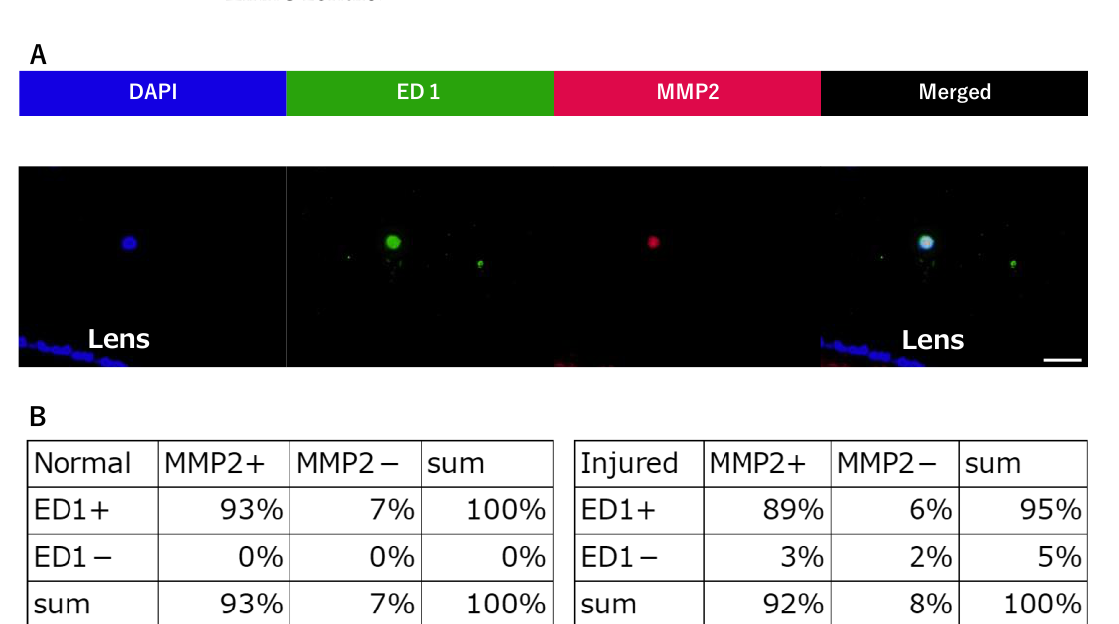
Figure 2. Increased infiltration of ED1-positive and MMP2-positive cells in Zinn’s zonule of the injured groups. ( A , B ) Immunofluorescence observations (magnified 100×) were performed on paraffin sections. ( A ) Nuclei were identified using DAPI (blue), macrophages using ED-1 (green), and Zinn’s zonule using anti-MAGP1 (red). ( B ) Nuclei were identified using DAPI (blue), MMP2-